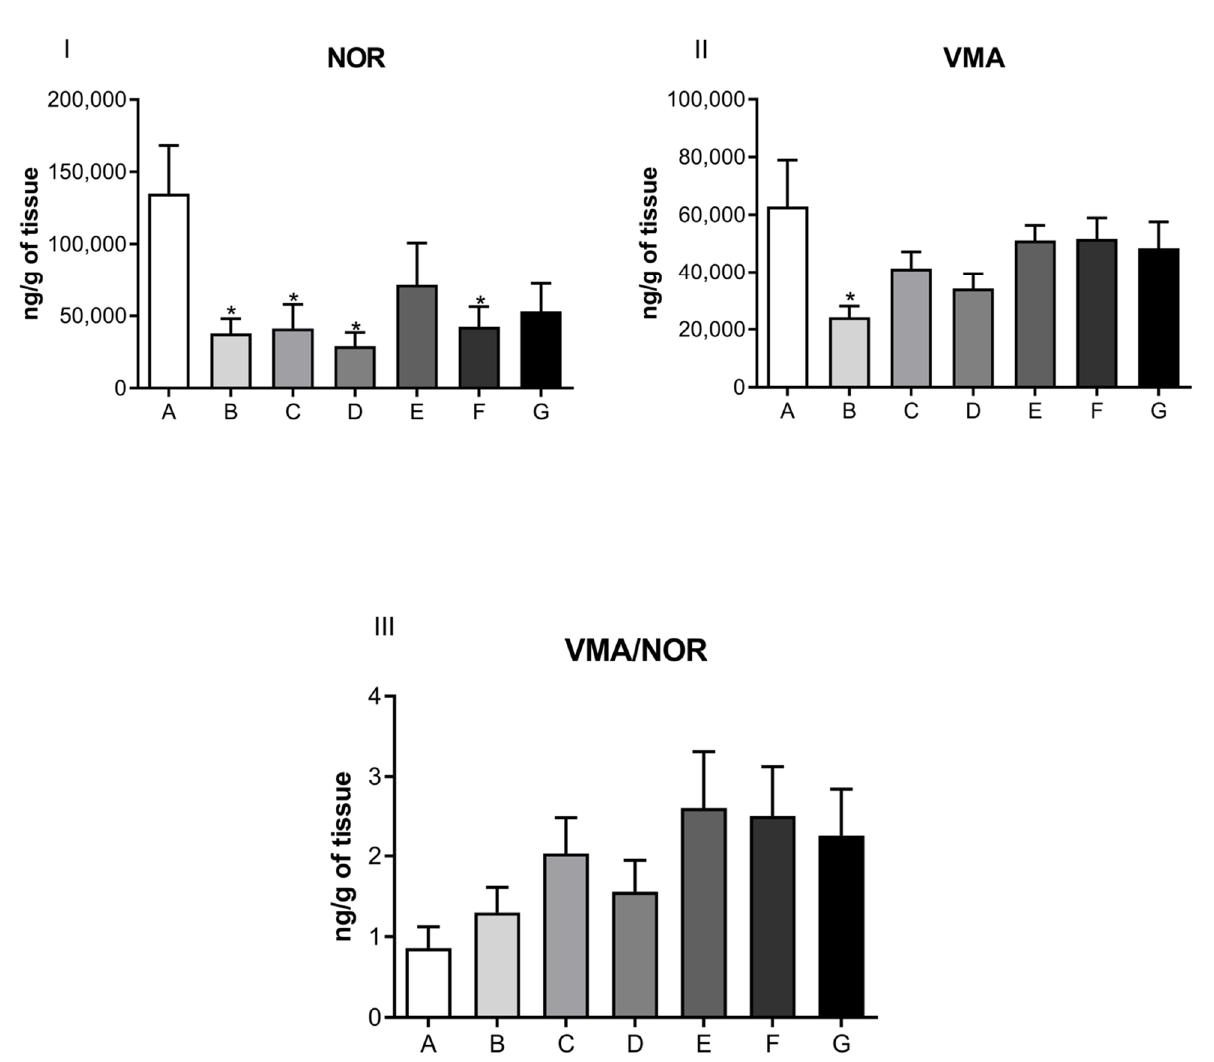
Figure 5. Neurotransmitter levels related to the noradrenergic system in the cardiac muscle of rats submitted to the depression model, treated or not with different doses of ketamine intraperitoneally. Panel ( I ): noradrenaline (NOR) levels (ng/g); Panel ( II ): vanillylmandelic acid (VMA) levels (ng/g); Panel ( III ): ratio of VMA/NOR (ng/g). A—control group (normal, not treated); B—control and treated with saline; C—depressed and treated with saline; D—depressed + ketamine 5 mg/kg; E—depressed + ketamine 10 mg/kg; F—depressed + ketamine 20 mg/kg; G—depressed + single dose of ketamine 10 mg/kg group The means and the respective standard errors are presented. N = 10. Animals per group * p < 0.05, ** p < 0.01 and *** p < 0.001 one-way ANOVA followed by Bonferroni test.